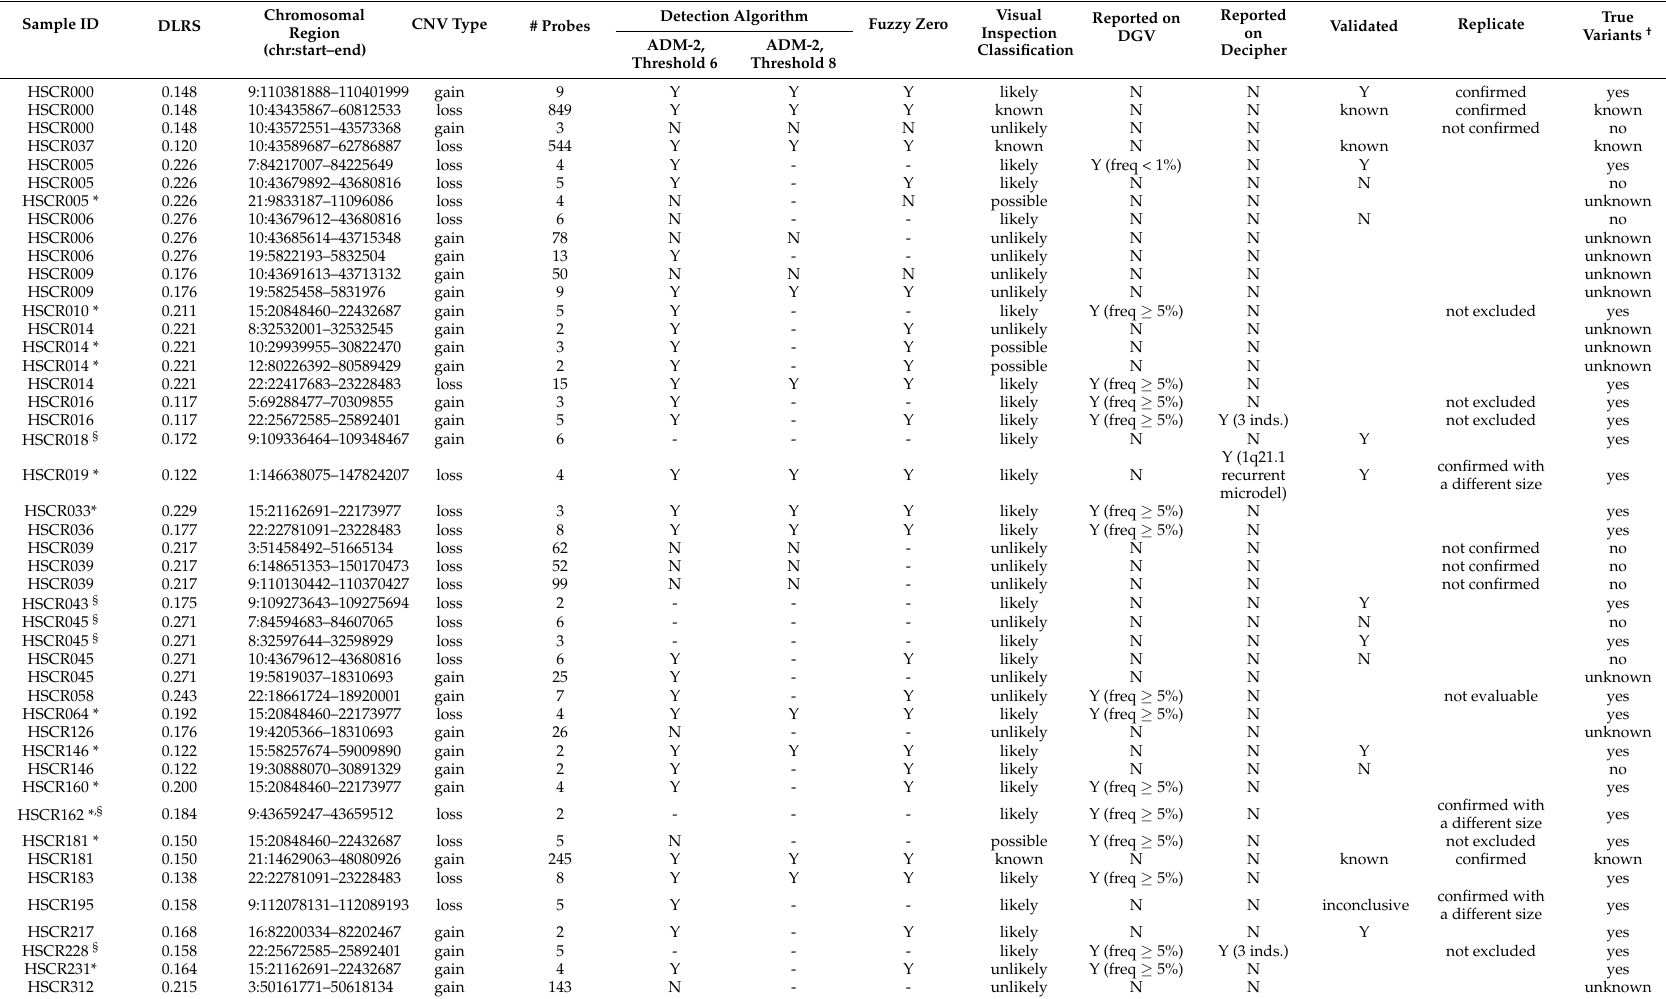
Table 2. Aberrations